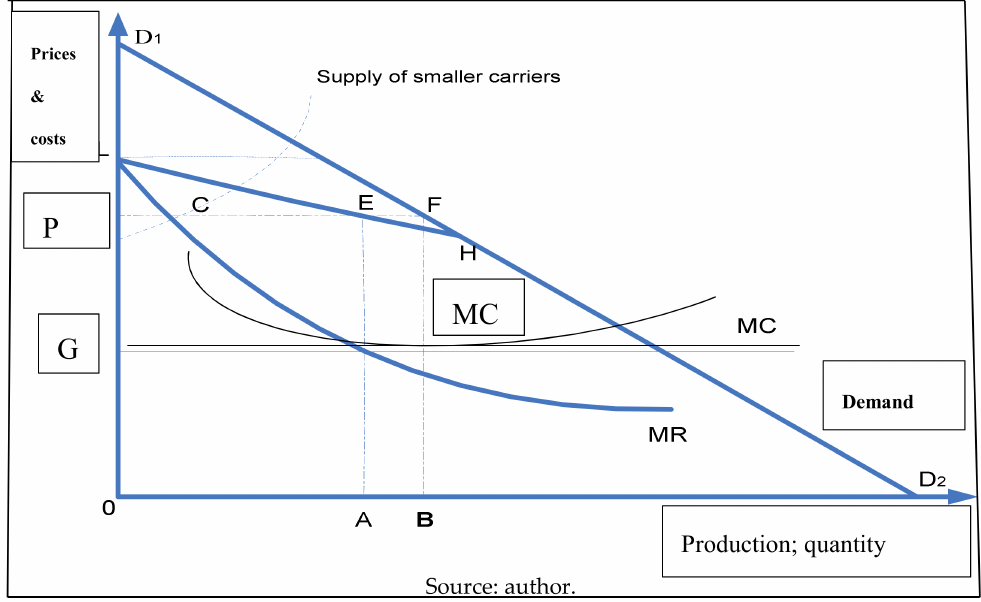
Figure 13. A group of oligopolies and a number of fringe competitive firms in Transpacific Eastbound. In CM, 9 containership companies are oligopolies, and earned $121b (2008), from an aggregate total share of fleet capacity 64%: AP Moller-Maersk, CMA CGM, Hapag-Lloyd, APL, Hyundai, (Hanjin), NYK, CSAV, and Zim 69 . They have a 71% share of total revenue (59% in TEUs carried). In May 2008, the 9 top companies had a share in the existing fleet of 69.4% (Lorange 2009) in TEUs. As shown, D 1 D 2 is the total demand curve of shippers for containership services over one particular route. From this we subtract what is offered by the fringe firms, leaving LEHD 2. Oligopolies exercise control over prices by adjusting production and with various co-operations, surcharges, negotiations and GRIs, to produce OA, satisfying the greater part of total demand: i.e., 60% (= LEHD 2 ); also PC =